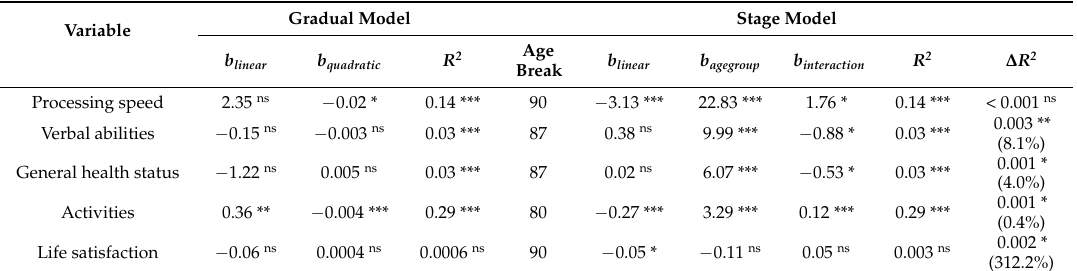
Table 3. Age relations in different domains applying a gradual versus applying a stage model.